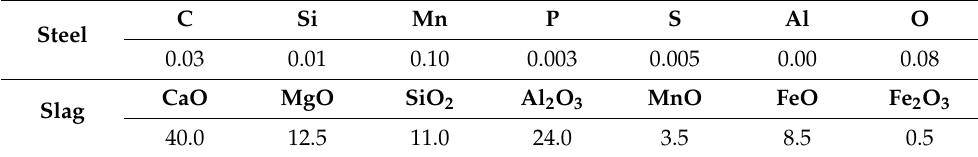
Table 1. The compositions of steel and slag before the refining (% mass).